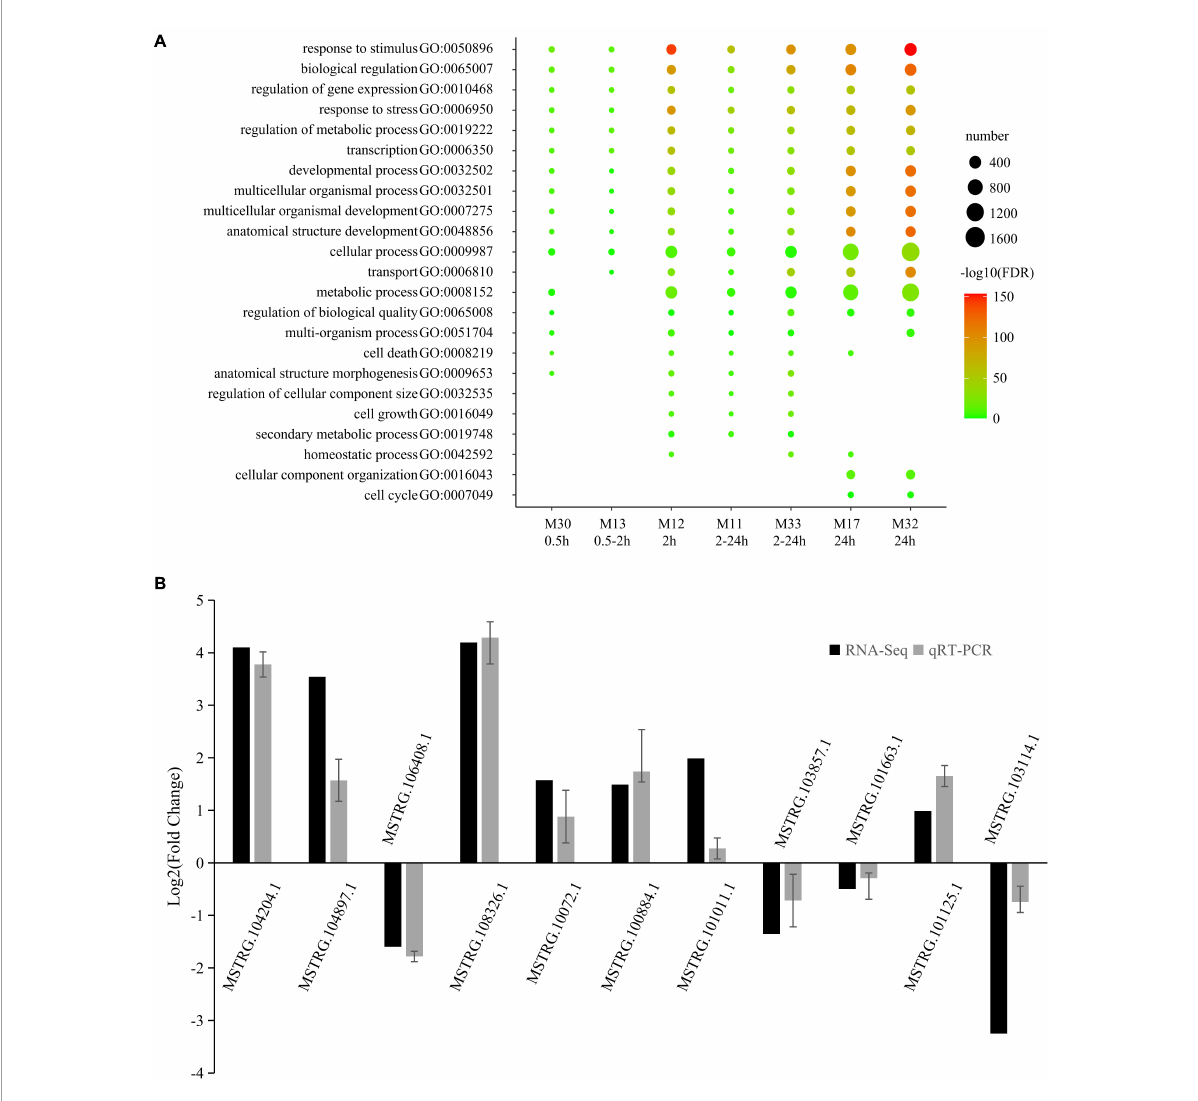
FIGURE4 Most representative GO terms of salt responsive modules and qRT-PCR validation. (A) Color legend represented –log 10 FDR. Point size represented number of genes enriched in the GO terms. The rows beneath the bubble chart showed module name, and the response time of each module. (B) The qRT-PCR histogram for each locus represents the mean ± standard error (SE) of three independent biological replicates, and the qRT-PCR are compared to fold-change data inferred from RNA-seq